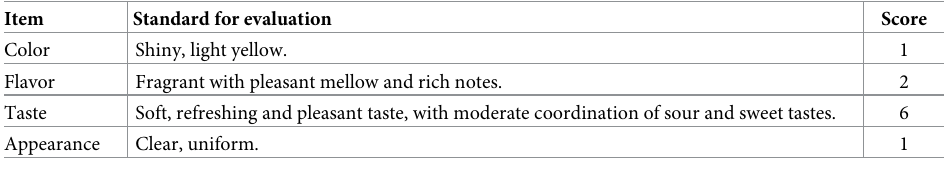
Table 1. Sensory evaluation indexes of rice